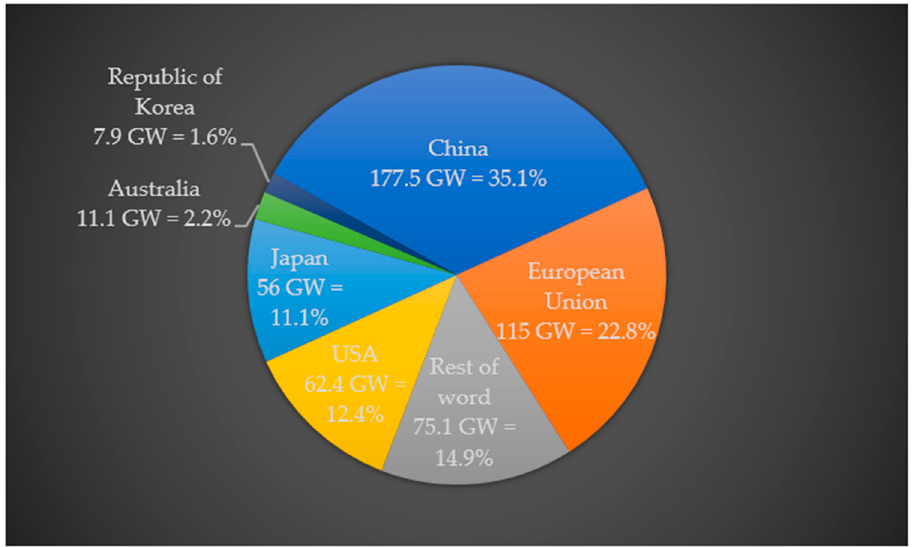
Figure 1. Estimated global solar photovoltaic capacity, by country and region in 2018, based on [18].